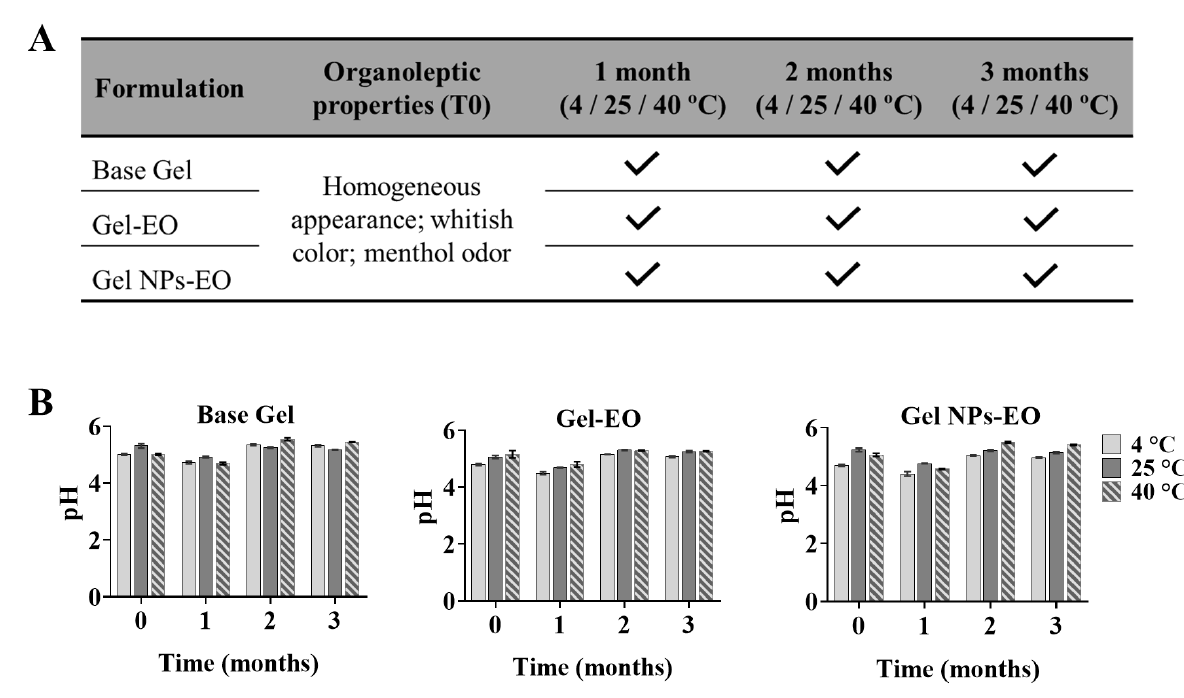
Figure 1. Evaluation of organoleptic properties ( A ) and pH ( B ) of gel samples (Base Gel, gel containing EO (Gel-EO) and gel containing EO-loaded chitosan nanoparticles (Gel NPs-EO)) at 4, 25 and 40 °C, over 3 months. Results are shown as the means ± SDs of 3 replicates.